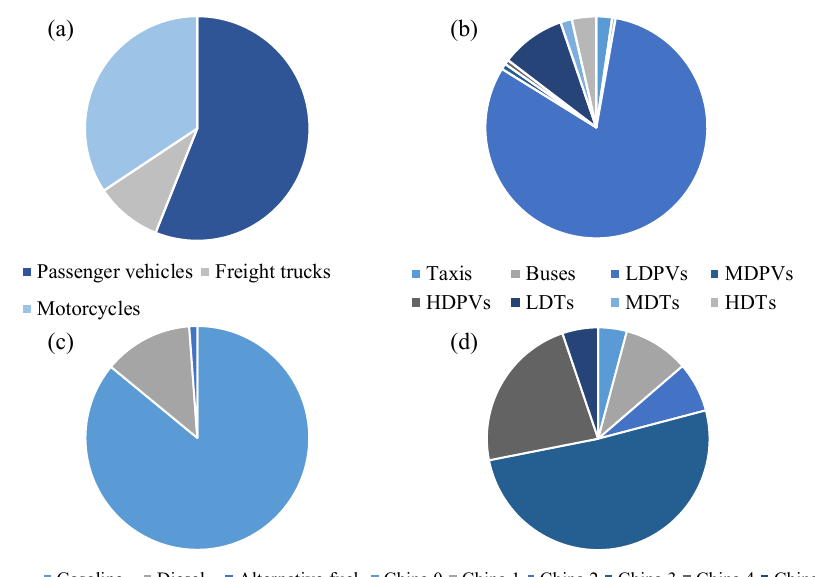
Figure 1. The percentages by vehicle types, fuel types and emission levels of China vehicle